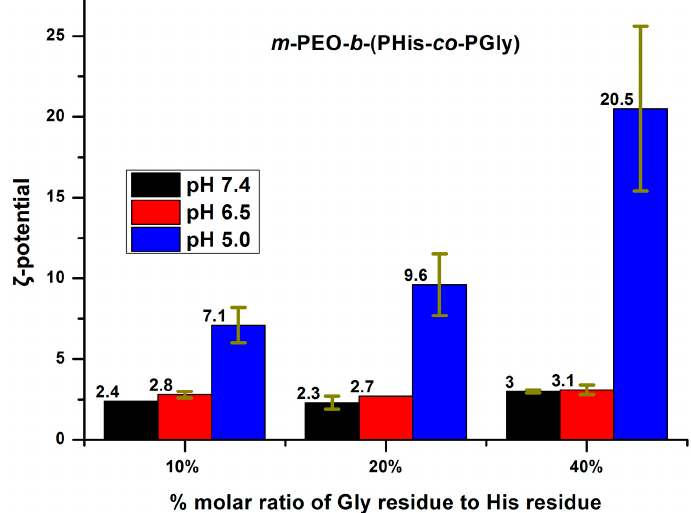
Figure 8. Zeta potential measurements of the synthesized polypeptides containing glycine residues as a function of pH and glycine to histidine residue molar ratio